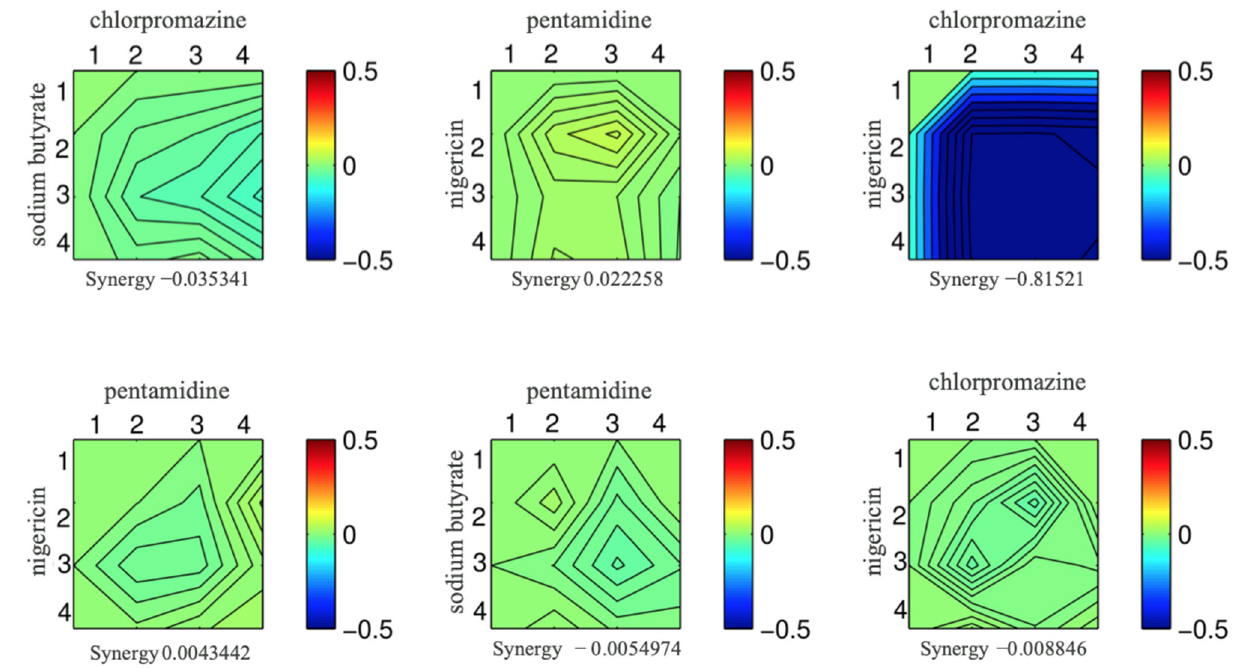
FIGURE 2 | Six examples from the set of drug combinations screened in a 4-by-4 dose matrixes. Each drug is present at 3 doses and a no drug control while the concentration increases along the x and y axis. The color of the heat map represents epsilon generated from the multiplicative model; blue indicates a synergistic interaction, and the epsilon score is presented underneath each